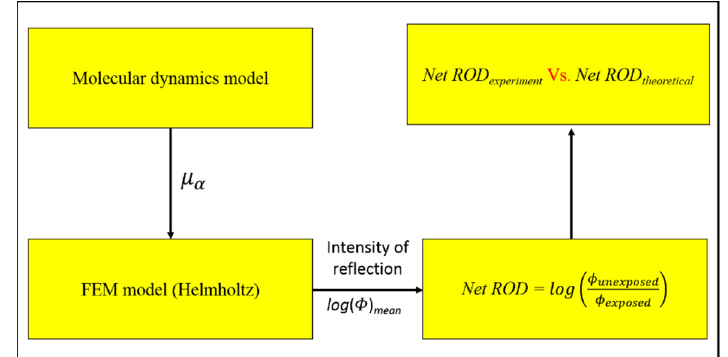
Figure 4. Flowchart summarizing approach to determine Net ROD .